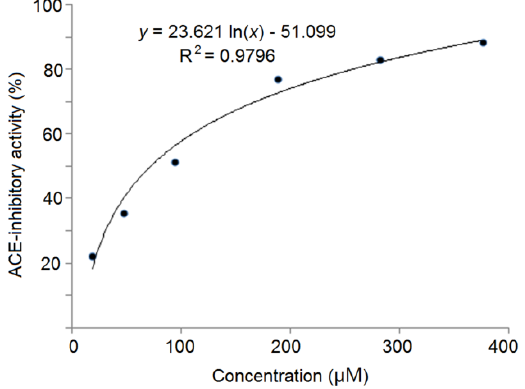
Figure 4. The ACE-inhibitory activity and the regression analysis of RWDISQPY .